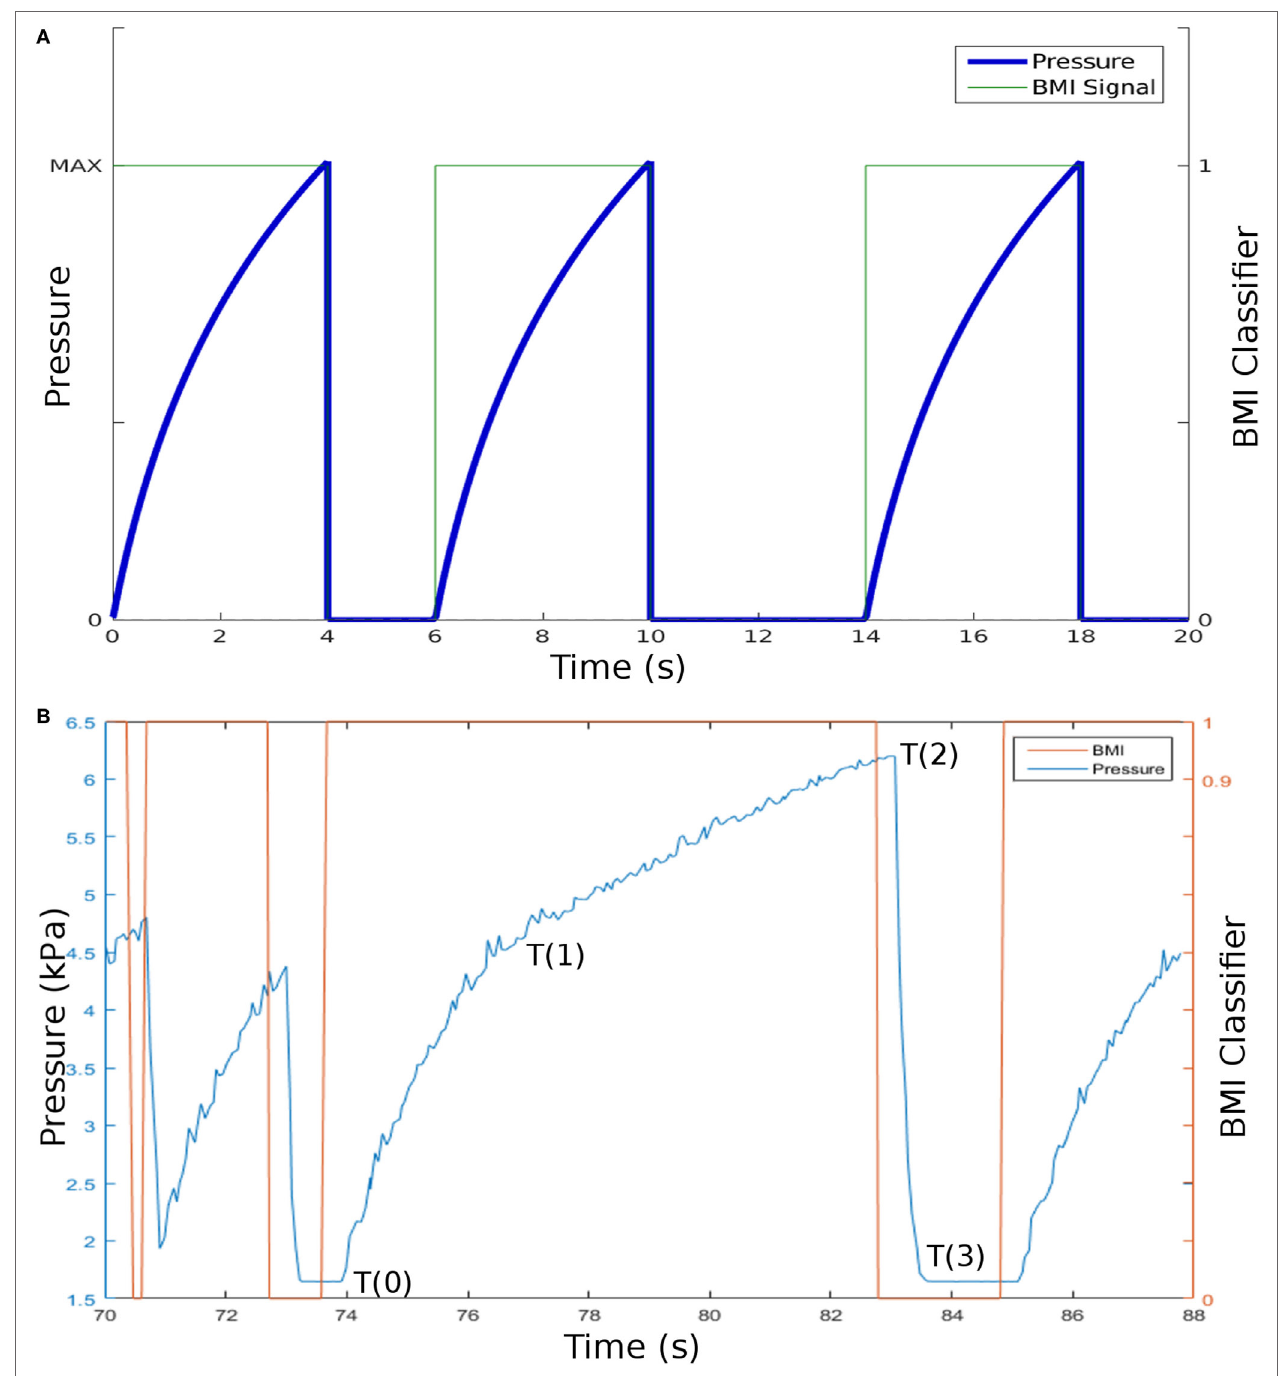
FigUre 7 | (a) Model data showing the electroencephalogram data generated from a brain–machine interface (BMI) device linked to the Soft Orthotic Physiotherapy Hand Interactive Aid system and the pneumatic pressure in one of the soft actuators. The pneumatic pressure increases (to a safe maximum) when the classifier is positive, and this pressure is released by opening a valve when the classifier is zero. (B) Example experimentally collected data showing how the BMI classifier data correlates to the increase in pneumatic pressure. T(0) to T(2) shows the pressure increase while the classifier is positive, and T(2) to T(3) shows the drop in pressure when the classifier is